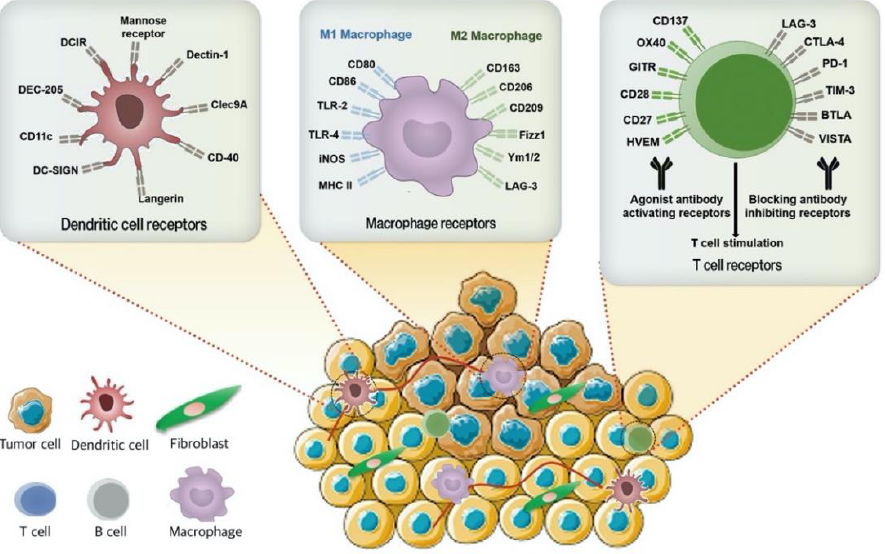
Figure 2. Schematic representation of the surface markers of immune cells including macrophage, dendritic cells, and T cells to design immune cell targeted NPs. Macrophage, dendritic cells, and T cells expressing different cell surface receptors are good therapeutic targets for TNBC therapies by modulation the tumor microenvironment (TME). DCIR, dendritic cell (DC) immunoreceptor; DC-SIGN, dendritic cell-specific intercellular adhesion molecule-3 grabbing non-integrin; DEC-205, CD-205; Clec9A, C-type lectin-like receptor on DC; TLR-2, toll-like receptor 2; TLR-4, toll-like receptor 4; iNOS, inducible nitric oxide synthase; MHC, major histocompatibility complex; Ym1/2, chitinase-like proteins; LAG-3, lymphocyte-activation gene 3; OX40 or TNFRSF4, tumor necrosis factor receptor superfamily member 4; GLTR, GATEWAY-compatible lentiviral tetracycline-regulated RNAi; HVEM, herpes virus entry mediator; CTLA-4, cytotoxic T lymphocyte-associated antigen-4; PD-1, programmed cell death-1 antibody; Tim-3, T-cell immunoglobulin and mucin domain 3; BTLA, B- and T-lymphocyte attenuator; VISTA, V-domain Ig suppressor of T cell activation.